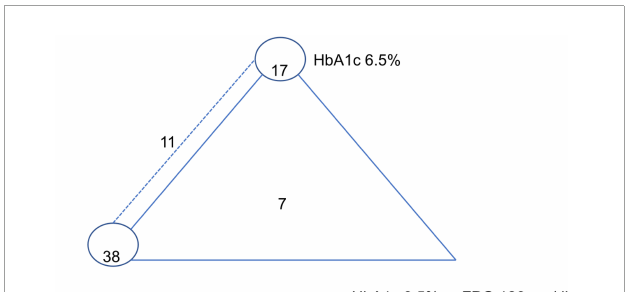
FIGURE2 Network plot of HbA1c 6.5%, FPG 126 mg/dl, and HbA1c 6.5% or FPG 126 mg/dl (reference standard: OGTT-2 h 200 mg/dl). The dashed line represents HbA1c 6.5%–FPG 126 mg/dl paired-test studies, the closed triangle with solid line represents triple-test studies, and the closed circle refers to single test studies.[7 studies investigated all three index tests (i.e., HbA1c ≥ 6.5%, FPG ≥ 126 mg/dl, and HbA1c/FPG); 11 studies investigated two index tests HbA1c ≥ 6.5%, FPG ≥ 126 mg/dl; 17 studies investigated only HbA1c ≥ 6.5%, 38 studies investigated only FPG ≥ 126 mg/dl].